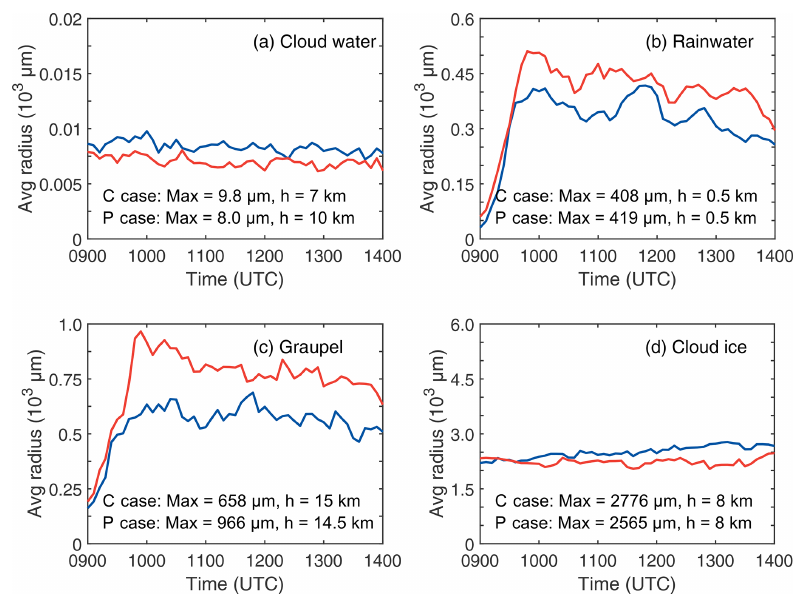
Figure 11. Temporal variation in the domain-averaged mean-mass radius for the different hydrometeors. (a) Cloud water, (b) rainwater, (c) graupel, (d) ice. The red lines represent the P case, and the blue lines represent the C case.